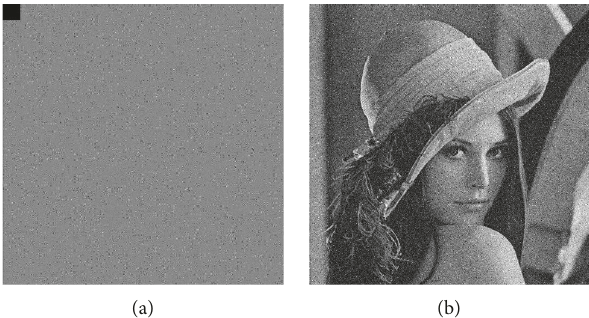
Figure 11: Results of attacks with cropping attack. (a) Encrypted image with (32 × 32) cropping size. (b) Decrypted